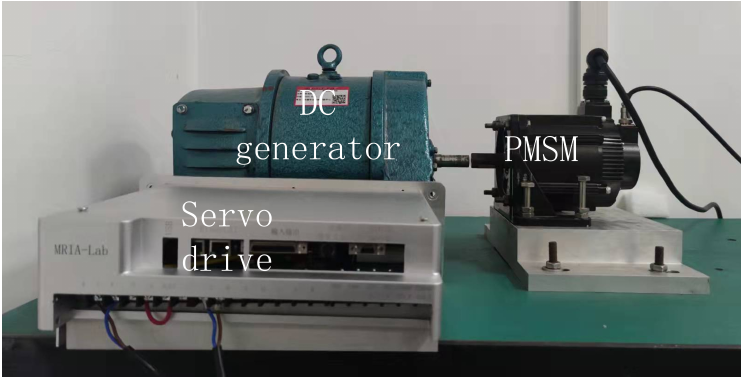
Figure 24. Experimental platform.